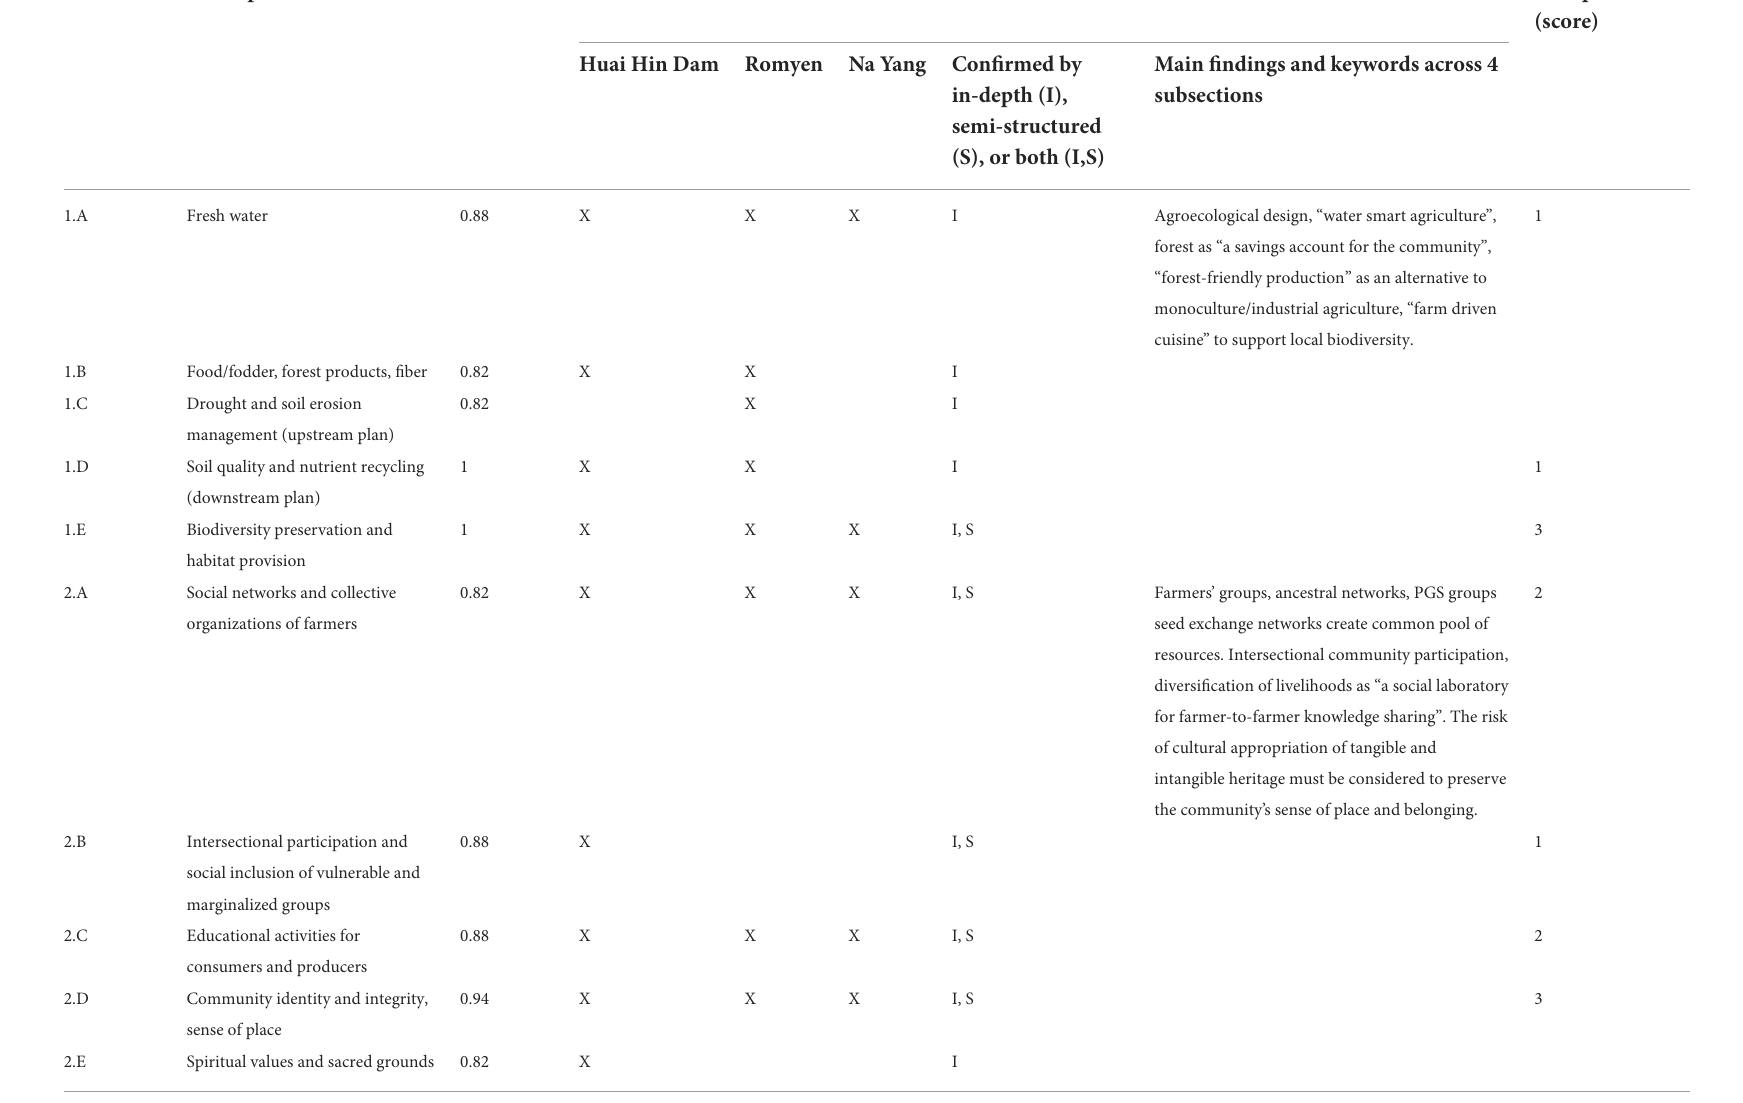
TABLE 4 Interpretation scored with 1 point for CVI > 0.90, 1 point for observation from all fields, 1 point for both in-depth and semi-structured